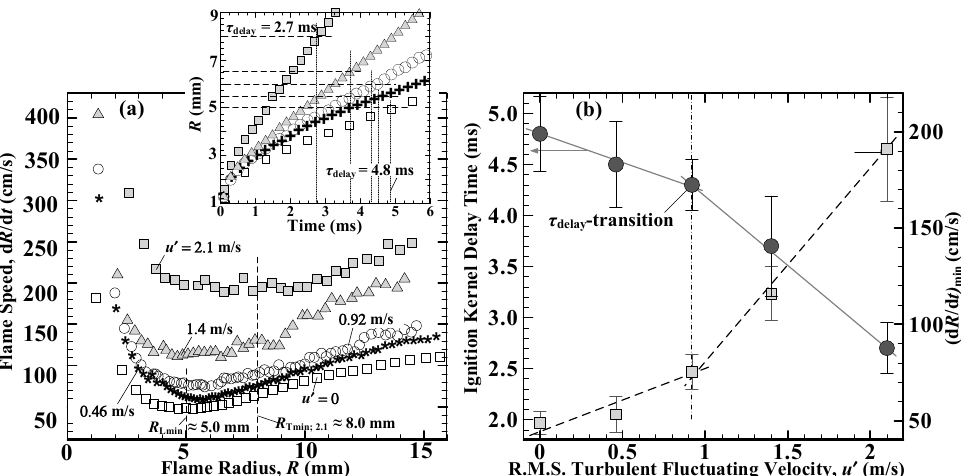
Figure 5. ( a ) Averaged flame speed plotted against flame radii at different turbulent fluctuating velocities ( u ′ ), obtained from the average flame radii versus time (the inset figure). ( b ) The ignition kernel delay time ( τ delay ) and minimum flame speed (d R /d t ) min as a function of r.m.s turbulent fluctuating velocity u ′ .